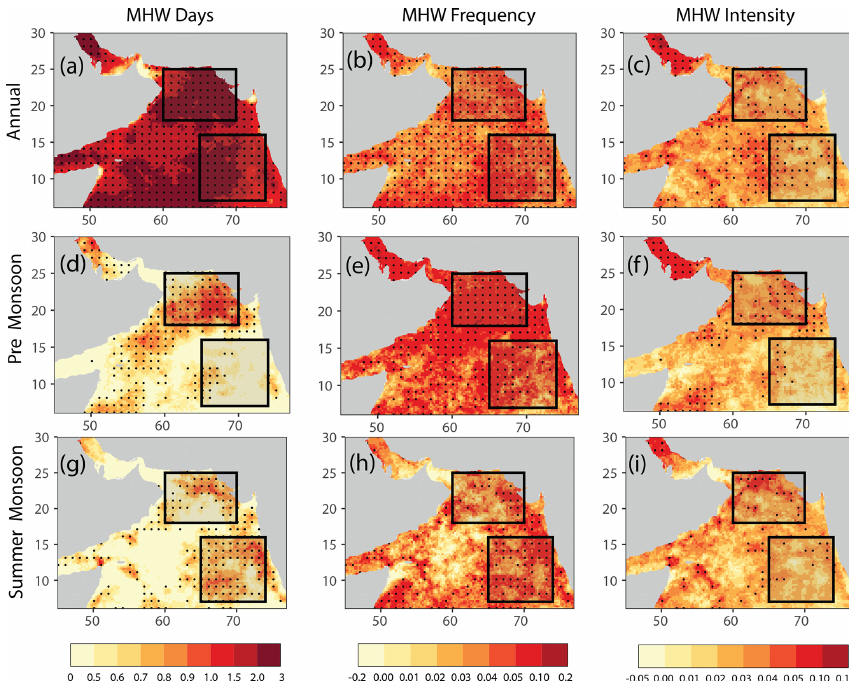
Figure 1. Trend for the MHW days ( dyr − 1 ; a , d , and g) , MHW frequency ( events per year; b , e , and h) , and MHW intensity ( ◦ Cyr − 1 ; c , f , and i) for the annual (a–c) , pre-monsoon (d–f) , and summer monsoon (g–i) periods. The trends within the 99% confidence limit are marked by stippling. The black boxes represent the north Arabian Sea (NAS) and the southeastern Arabian Sea (SEAS). The trends are calculated for the period